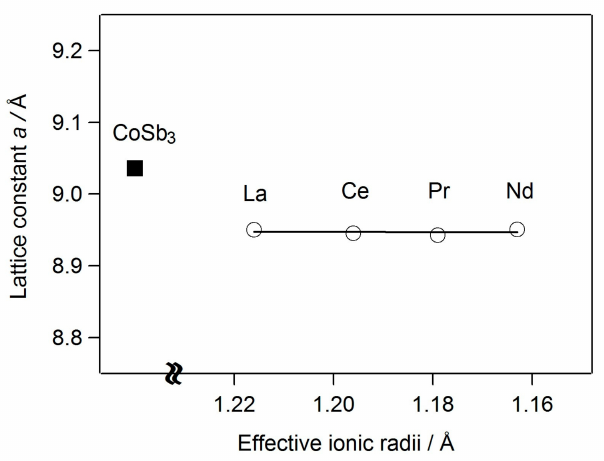
Figure 4. Lattice constant of the Ge-substituted cobalt skutterudite